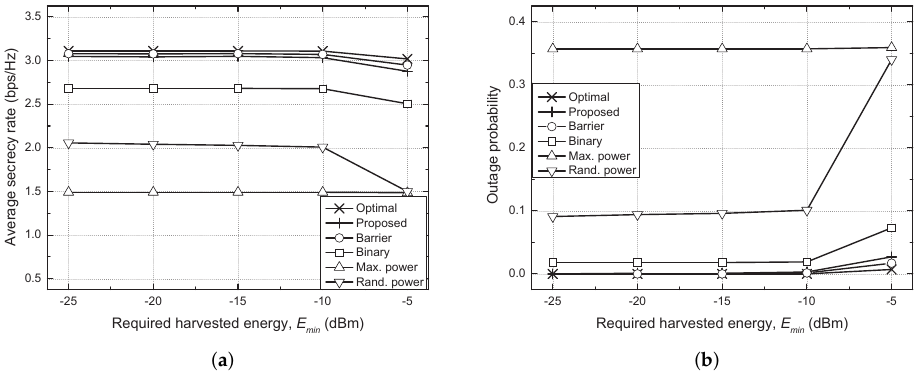
Figure 3. Performance comparison against required harvested energy ( E min ). ( a ) Average secrecy rate vs. E min . ( b ) Outage probability vs. E min .